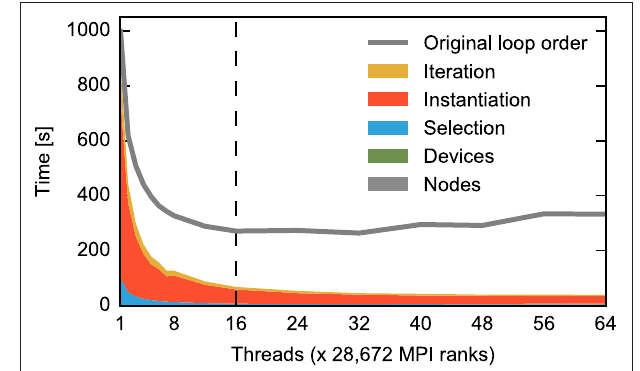
FIGURE 6 | Time required for the construction of the large neuronal network using the alternative loop order. Color code and data ranges are the same as in Figure 3B showing the construction time prior to the reorganization of loops. The times required to create the network nodes and to connect devices and neurons are too small to be visible in the present graph. Listing 3 illustrates the algorithm. The gray curve shows the total construction time from Figure 3B for comparison. The dashed vertical line indicates the number of physical cores available on a compute node. The double-logarithmic representation of the same data in Figure 7 illustrates the scaling at large numbers of threads. Network construction is performed with instrumented code incurring runtime overhead compared to Figure 7 , see Section